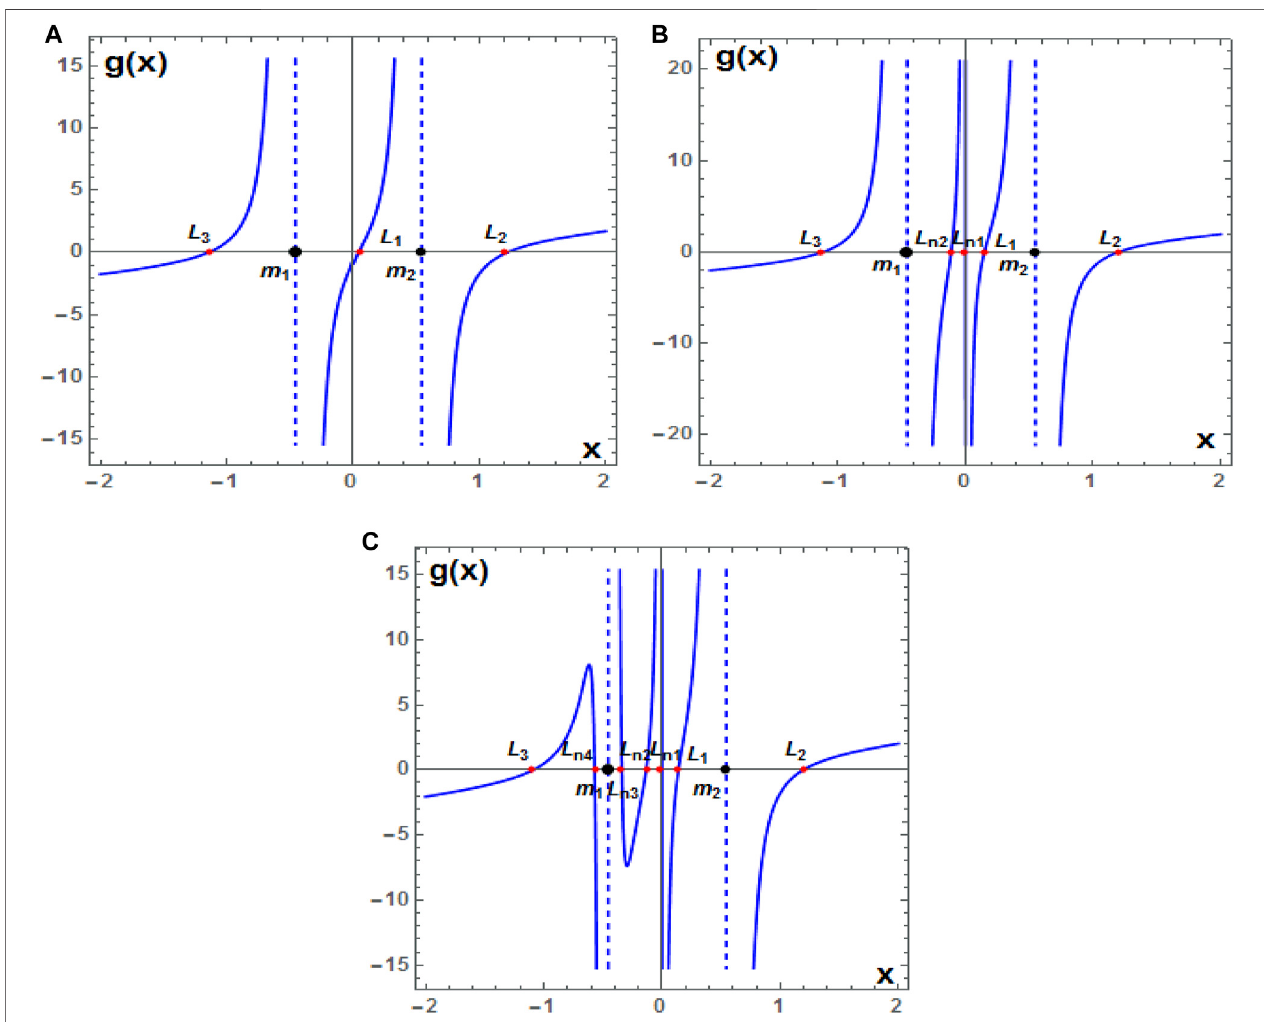
FIGURE1|(A) Positionsofthethreecollinearequilibriumpoints(reddots) L i i =1,2,3,for M b =0.00005. (B) Fivecollinearpoints L i , i =1,2,3, L ni , i =1,2,for M b =0.05. Inbothframes,wehave fi xed μ =0.455, σ 1 =4×10 − 5 , σ 2 =3×10 − 5 , σ 3 =2×10 − 5 , σ 4 =10 − 5 , A 3 =0.02, T =0.01, q 2 =0.99,and q 1 =0.8. (C) similartopanel (B) ,butforthe caseof seven collinear points inwhich σ 1 = 0.01, σ 2 = 0.03, σ 3 = 0.05, σ 4 = 0.07, and A 3 = 0.001. The positions of the primary bodies, m i , i =1,2, are denoted by black dots.